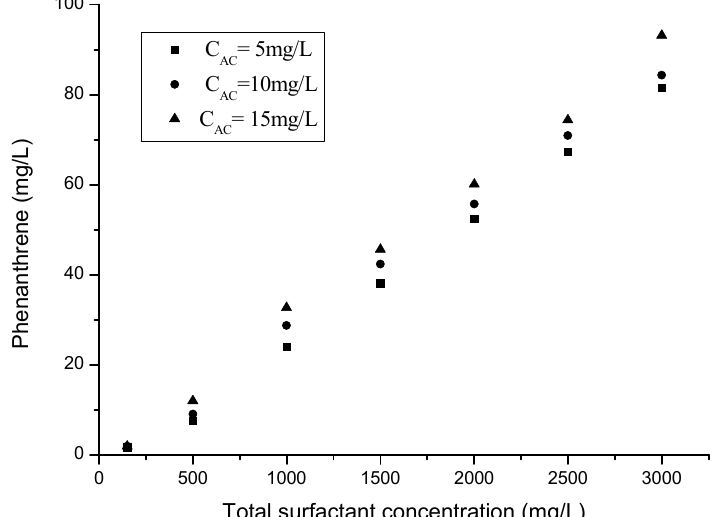
Figure 5. Solubilization of phenanthrene with coexisting acetic acid (5, 10, and 15 mg / L) in the TX100-Rham mixture at CMC, 500, 1000, 1500, 2000, 2500 and 3000 mg / L (the mass ratio between TX100 and Rham was 3:1, and C AC is the concentration of acetic acid).